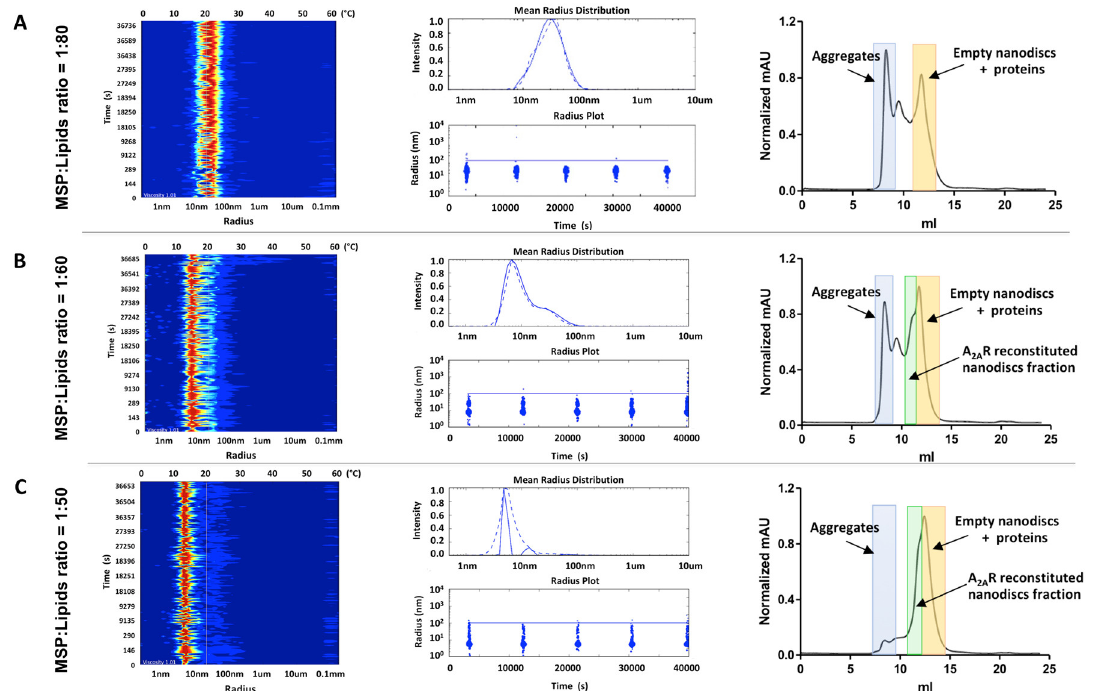
Figure 4. In situ DLS analysis of three A 2A R-POCP: POPG nanodisc samples produced with different MSP:lipid ratios. The MSP:lipid ratios were 1:80 ( A ), 1:60 ( B ) and 1:50 ( C ). The left panels show the size distribution plot in the form of a signal heat map followed by the in situ analysis panel showing the graphs of the radius distribution and radial distribution plot (the blue spot diameter represents the relative scattered light intensity of the detected particles in arbitrary units) for each of the ratios. The corresponding SEC chromatograms for each MSP:lipid nanodisc samples are shown on the right hand side.